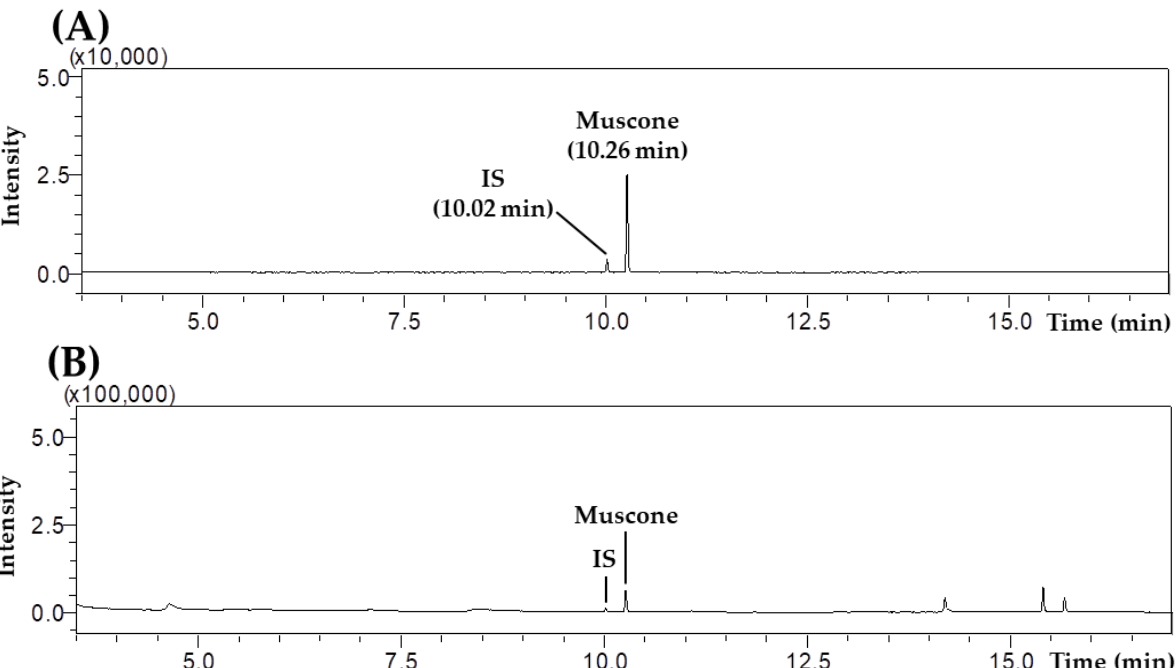
Figure 3. Representative GC–MS/MS chromatograms of the standard solution ( A ) and GJD–1 sample ( B ). The concentrations of muscone and IS in the mixed standard solution were 5.00 µg/mL and 1.00 µg/mL, respectively.